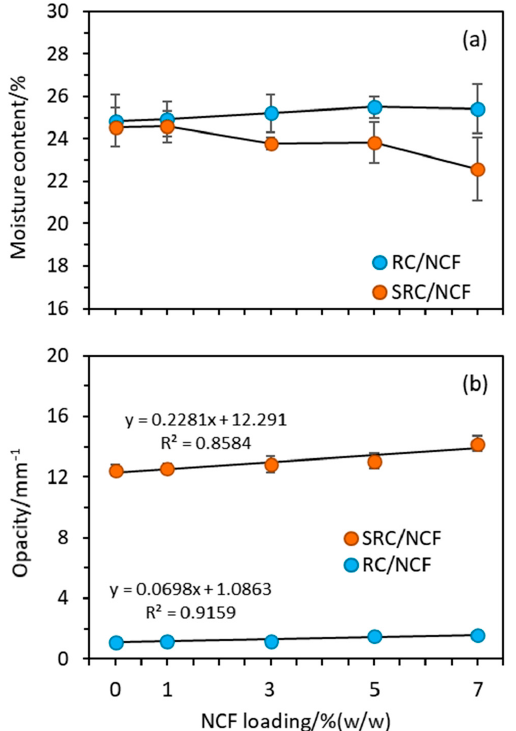
Figure 2. Plots of ( a ) moisture content and ( b ) opacity against NCF loading for the SRC / NCF and RC / NCF films.